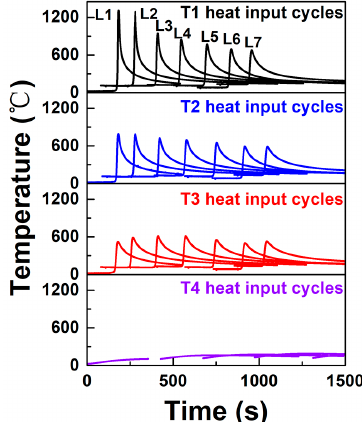
Figure 6. Temperature filed measured at the T1–T4 positions for the L1–L7